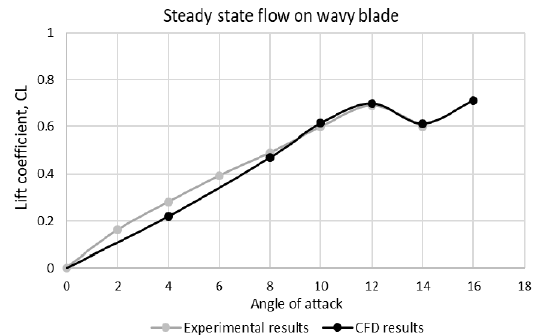
Figure 6. The aerodynamic characteristics of both blades at steady flow conditions.